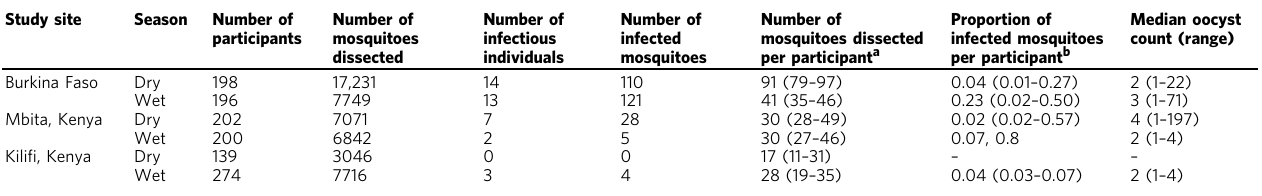
a Median (interquartile range) b Median (range), only data from infectious individuals included